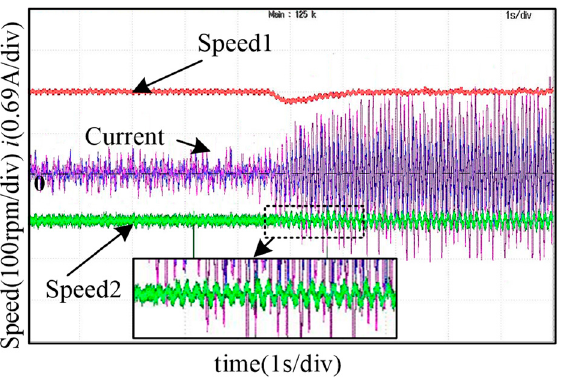
Figure 20. The current and speed waveform of speed closed − loop decoupling control without current compensation under load step from 0 N·m to 4 N·m.